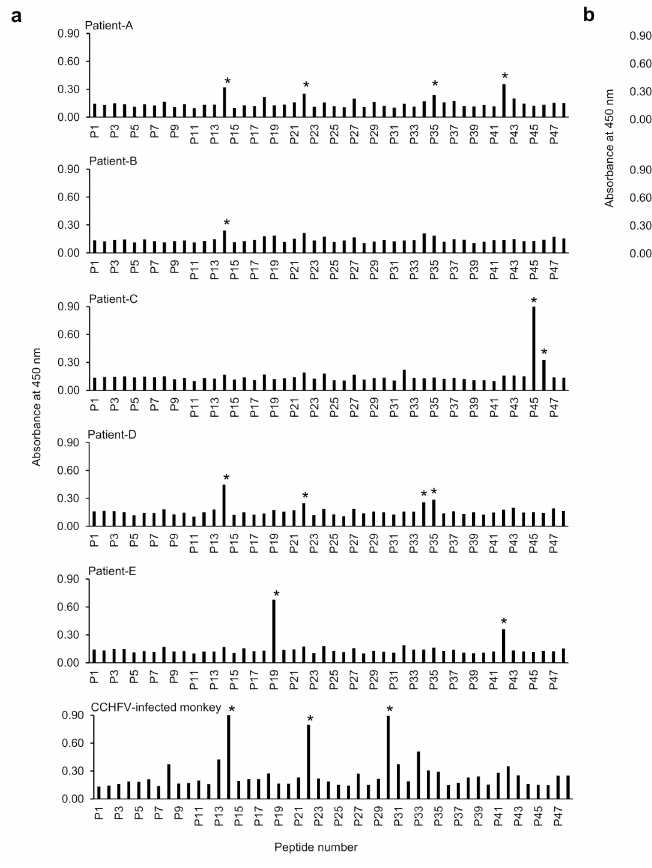
Figure 2. Reactivities of polyclonal antibodies to the PEPscreen library of CCHFV NP. The peptides are numbered according to their positions (see also Figure 1 and Table 2). ( a ) The serum samples of CCHF patients and a CCHFV-infected monkey or MIAFs to NSDV and DUGV ( b ) were diluted at 1:500 and used as primary antibodies. Experiments were duplicated, and the averages are shown. Significantly higher OD values are indicated by asterisks.